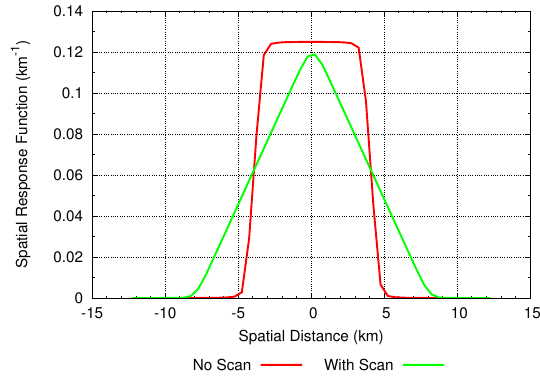
Fig. 1. Normalised spatial response function for the UV-VIS in east–west direction in ground coordinates. Red: without scan. Green: with